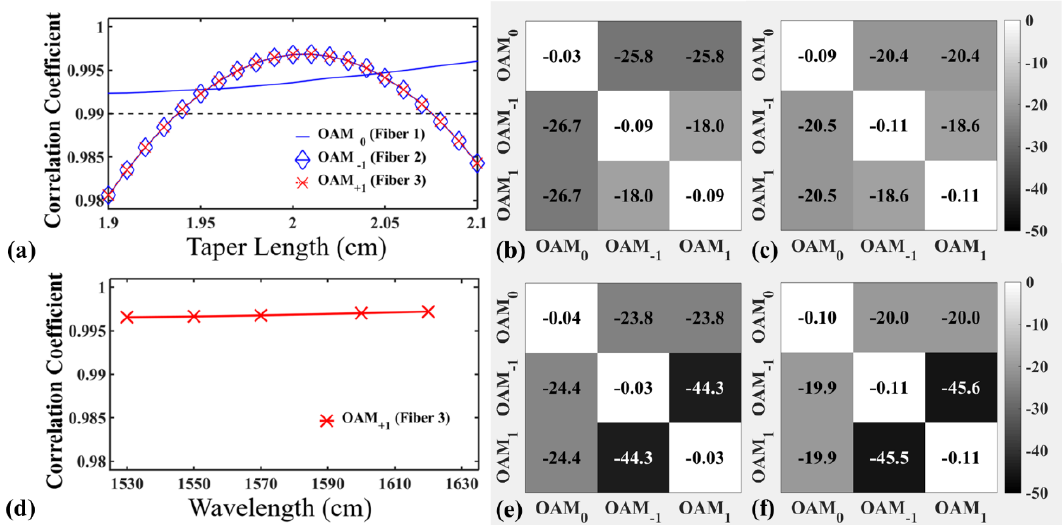
Figure 6. Calculated correlation coefficients of OAM-MSPL with ( a ) taper lengths around 2 cm when injecting light into all of the cores and ( d ) with wavelengths in the C-band and L-band when injecting light into the Fiber 3 core. Calculated mode crosstalk matrices of pairs of the PLs with taper lengths of ( b ) 1.95 cm and ( c ) 2.05 cm, or with wavelengths at ( e ) 1530 nm and ( f ) 1620 nm.